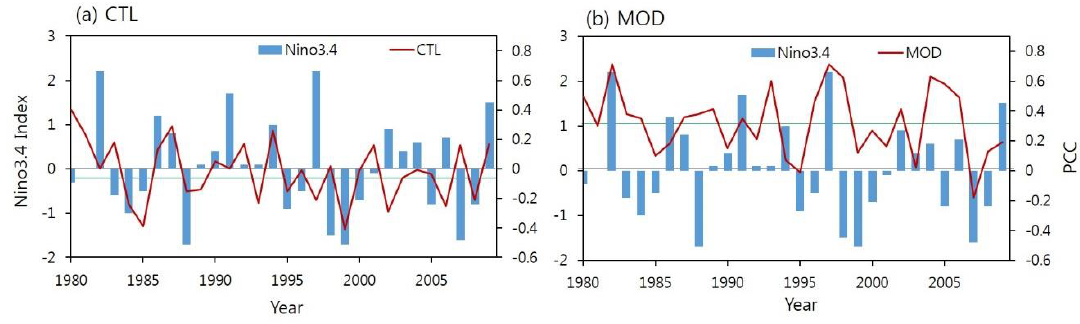
Figure 3. Year-to-year variations of the precipitation prediction skill (red line) measured by pattern correlation between observation and predicted JJA rainfall from ( a ) CTL and ( b ) MOD during 1980 – 2009. Pattern correlations were calculated over the EASM domain (5 – 40° N, 100 – 140° E). The blue bars represent observed DJF Nino3.4 SST Index (°C).